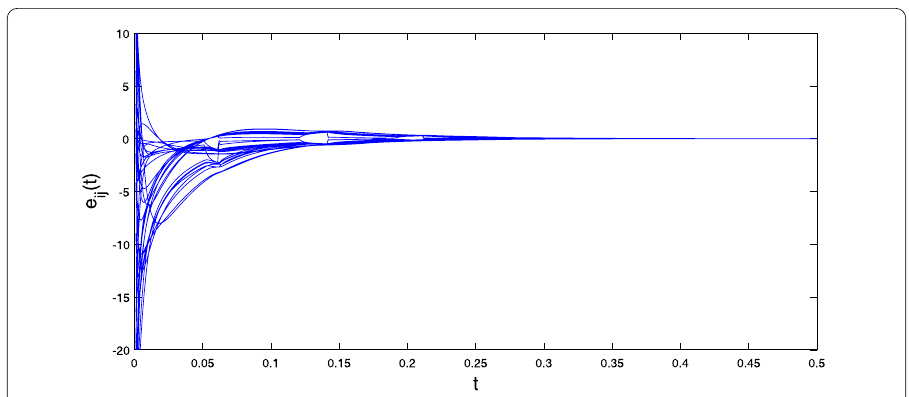
Figure 1 The orbits of the synchronization errors e ij ( t ), i = 1,2, ... ,10, j =